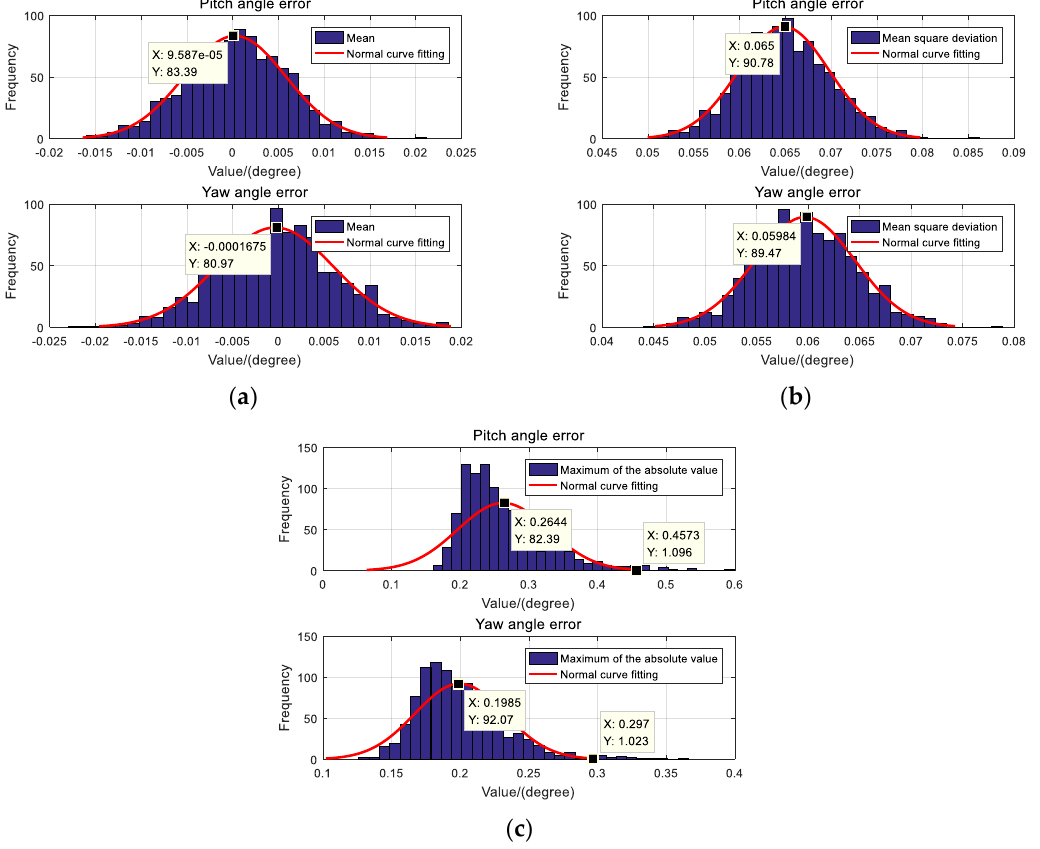
Figure 9. Results of Monte Carlo simulation. ( a ) Mean of estimation errors,( b ) Mean square error of estimation errors,( c ) Maximum of the absolute value of estimation errors.